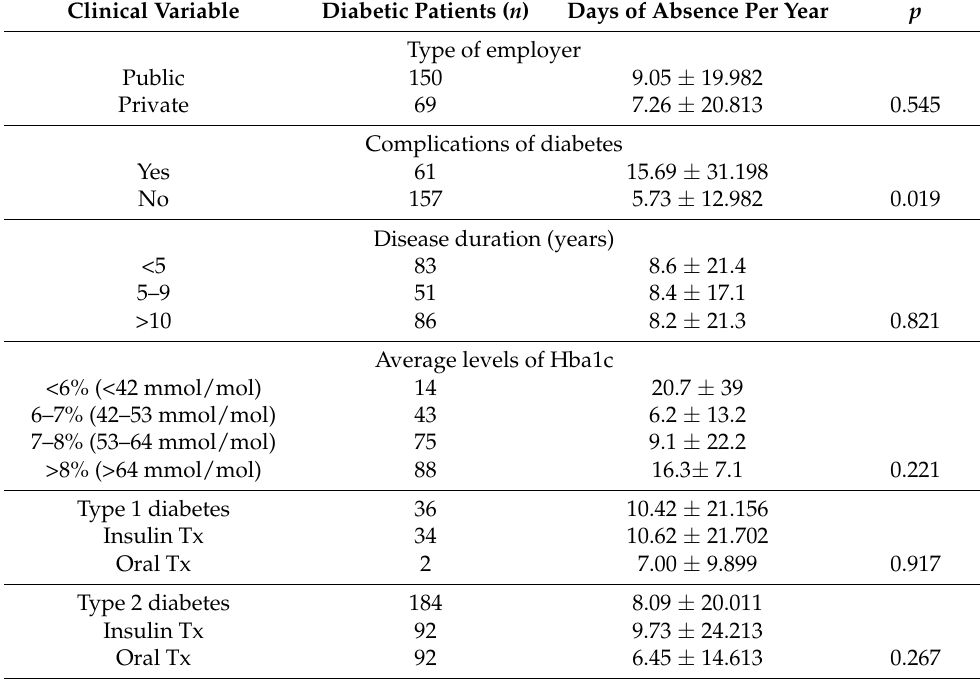
Table 4. Clinical variables associated with